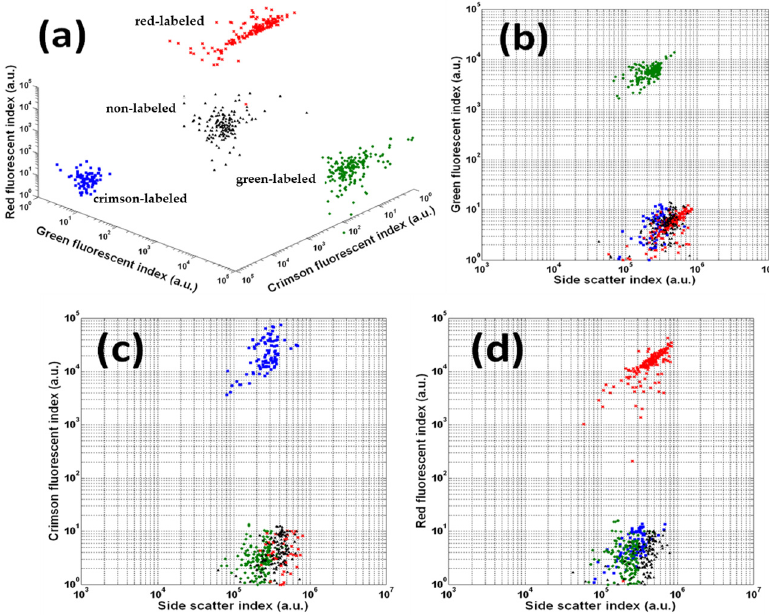
Figure 6. Flow cytometer detection results for the mixed sample composed of green-, red-, crimson-labeled and non-labeled particles: ( a ) 3D scatter plot without side-scatter index; ( b – d ) 2D scatter plots with different fluorescent and side-scatter indices.